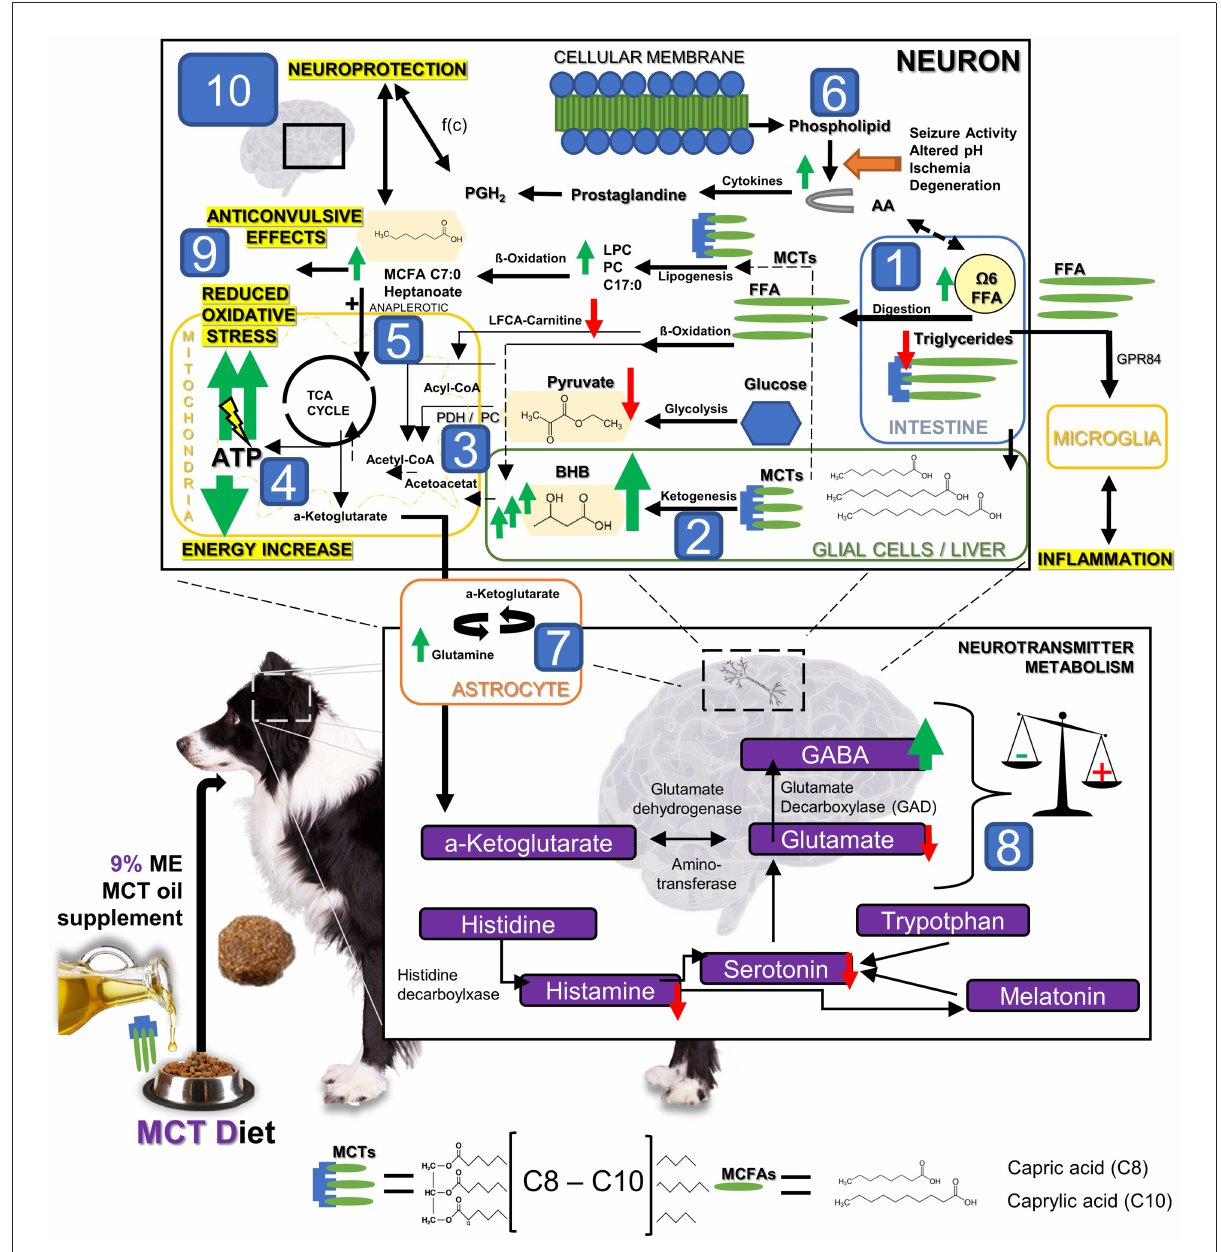
FIGURE5 The hypothetical metabolic response to MCT oil supplementation: The dietary supplementation of MCT oil induces significant metabolic changes. Substantial changes in the lipid, energy and neurotransmitter metabolism have been detected in dogs with idiopathic epilepsy after 3 months under MCT DS as a nutritional, therapeutic approach. In brief, after oral intake, [1] MCT can be degraded in the intestinal lumen by lipases into MCFAs. MCFAs can be directly absorbed, transported into the liver and metabolized into C4 ketone bodies, such as beta-hydroxybutyrate (BHB). BHB levels [2] were significantly increased in all dogs during MCT consumption compared to the control oil phase. Based on these findings, MCT might lead to a significantly increased anaplerotic influx into the TCA cycle [3] and thereby evokes an additional production of adenosine triphosphatase (ATP) via the mitochondrial respiratory chain resulting in a compensation of epilepsy associated energy deficits [4]. Moreover, Pyruvate was found being especially decreased in MCT responders [3]. The compensation of energy deficits may thus also be given via (a) an increase in the enzymatic activity of the pyruvate dehydrogenase (PDH) activity, or/and (b) the promoted entry of oxaloacetate into the TCA by increased pyruvate carboxylase activity (PC). PDH and PC may be here both the key metabolic enzymes relevant for overcoming energy shortage under MCT consumption via the use of pyruvate. Furthermore, an additional de-novo lipogenesis from MCT into other MCFA via ß-oxidation leading to anaplerotic and neuroprotective effects has been hypothesized in the past [5]. Some prostaglandins deriving from arachidonic acid (AA) play significant roles in the processes of neurodegeneration and neuroinflammation, but also neuroprotection and regeneration. Prostaglandine can induce both depending on its concentration ratios of different types of prostaglandin